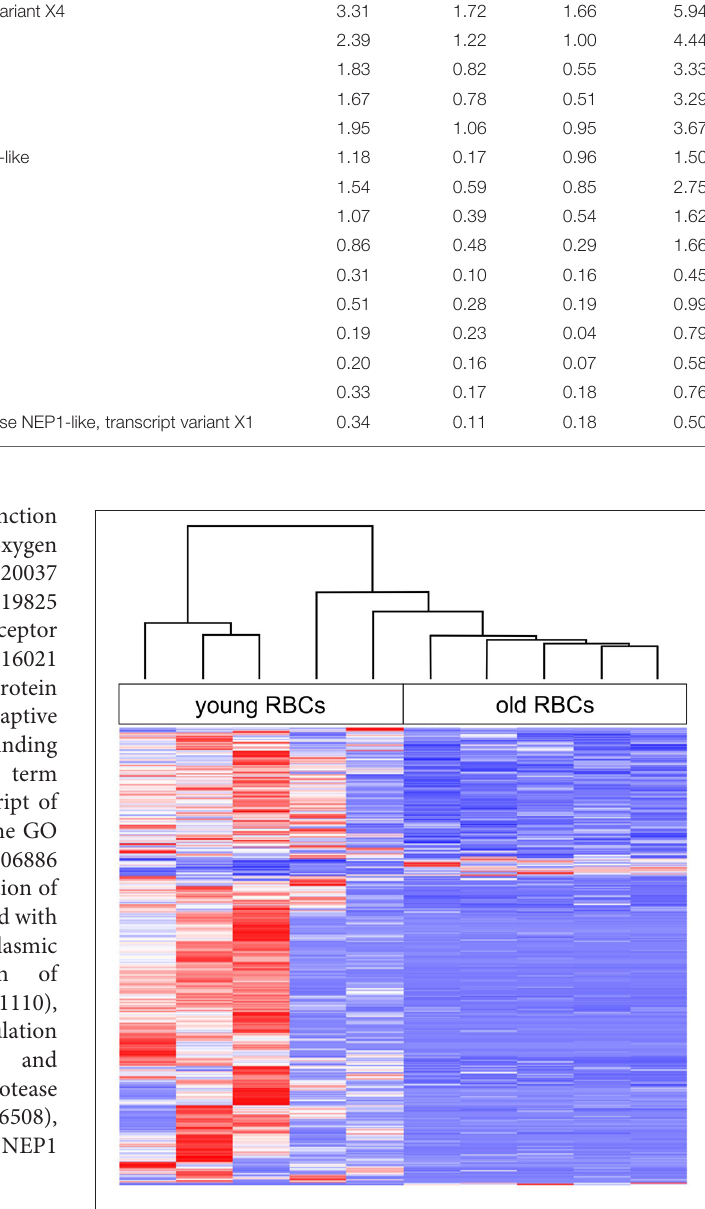
protein 215 (XM_014194795), the cancer susceptibility candidate 1, transcript variant X2 (XM_014153053), and the corin, serine peptidase (XM_014206310). Negative log 2 -fold changes of five genes with unknown products were up to − 6.5 in old erythrocytes ( Table S2